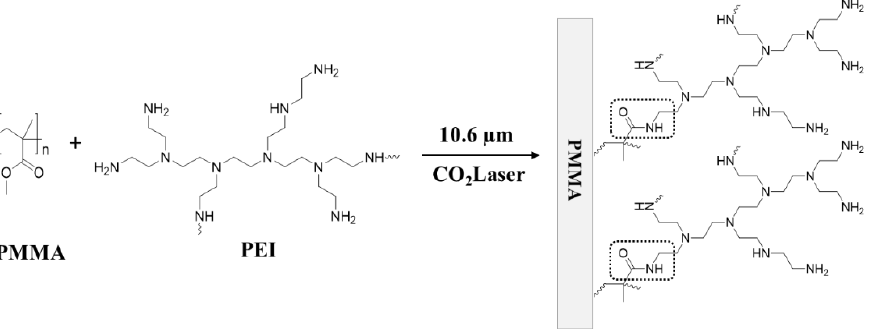
Figure 1. Schematic drawing of aminolysis reaction for laser-assisted PEI grafting on PMMA.